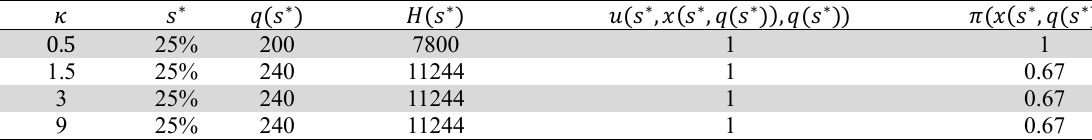
Solutions of the proposed model with 𝜑 = 1.5